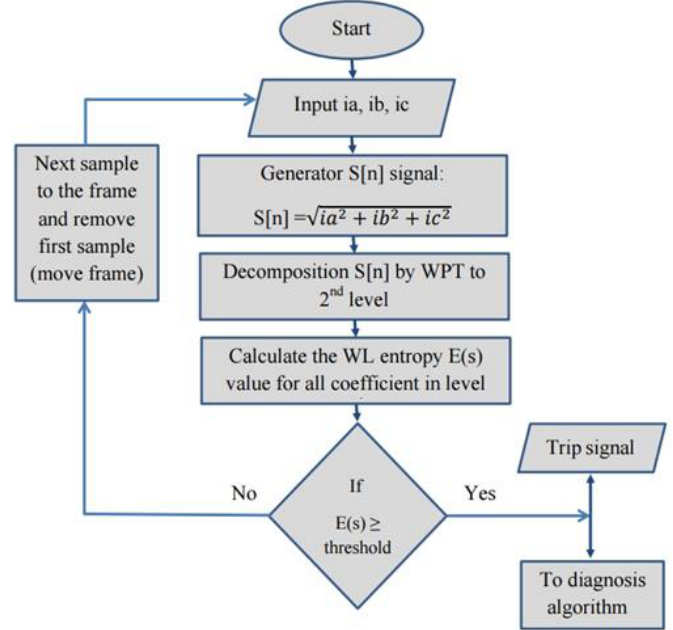
Figure 11. Fault detection using moving frame algorithm.